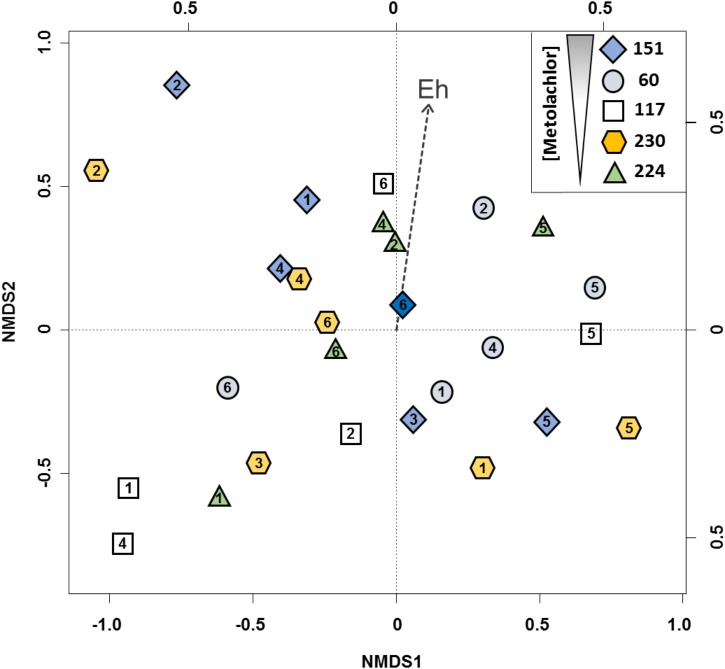
2D-NMDS ordination of bacterial community profiles from the Ariège alluvial plain groundwater obtained by T-RFLP analysis from 5 wells 151, 60, 117, 230, 224. Wells feature a decreasing gradient of MET concentrations, numbers in the objects indicate the groundwater collection campaigns. 1: May 2012, 2: July 2012, 3: September 2012, 4: December 2012, 5: February 2013, and 6: May 2013. Plot stress = 0.19.